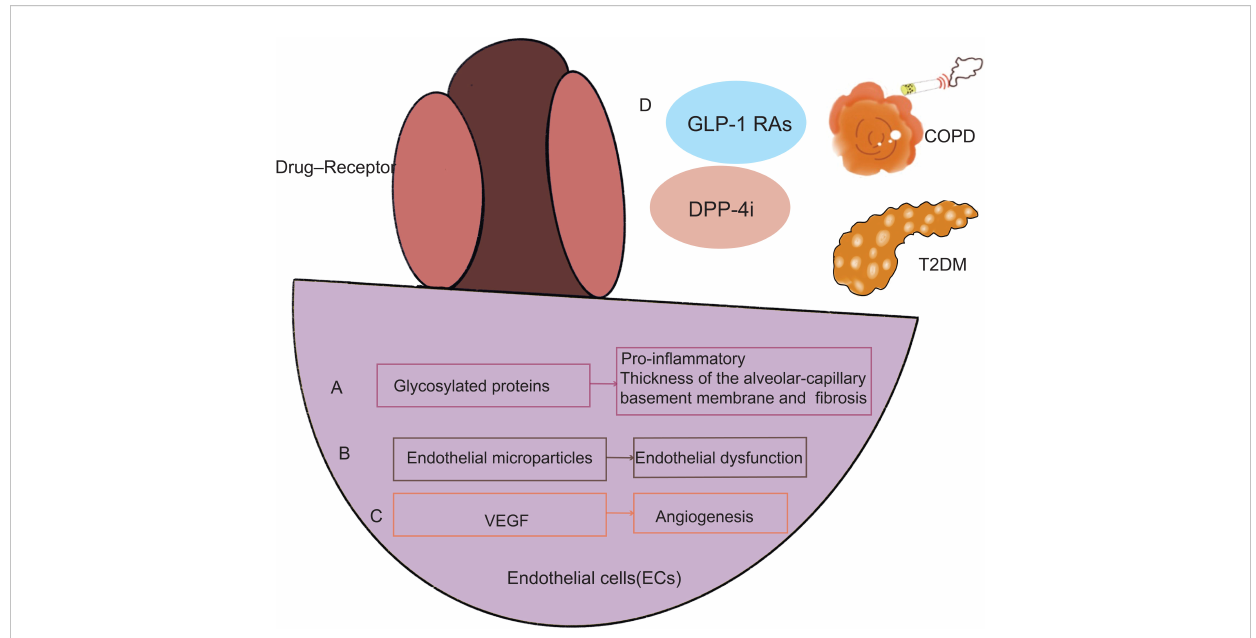
FIGURE 3 In endothelial cells, COPD and T2DM create a similar pathogenic pathway. Endothelial cells in T2DM may impact how a lung disease develops in the end. Endothelial cells become dysfunctional in patients who have T2DM and COPD because of the accumulation of glycosylated proteins (A) , a rise in endothelial microparticles (EMPs) (B) , and an increase in VEGF (C) . GLP-1 RAs, GLP-1 RAs and DPP-4i can treat COPD and diabetes simultaneously (D) . GLP-1 RAs, GLP-1 receptor agonists; DPP-4i, Dipeptidyl peptidase 4 inhibitors; VEGF, Vascular endothelial growth